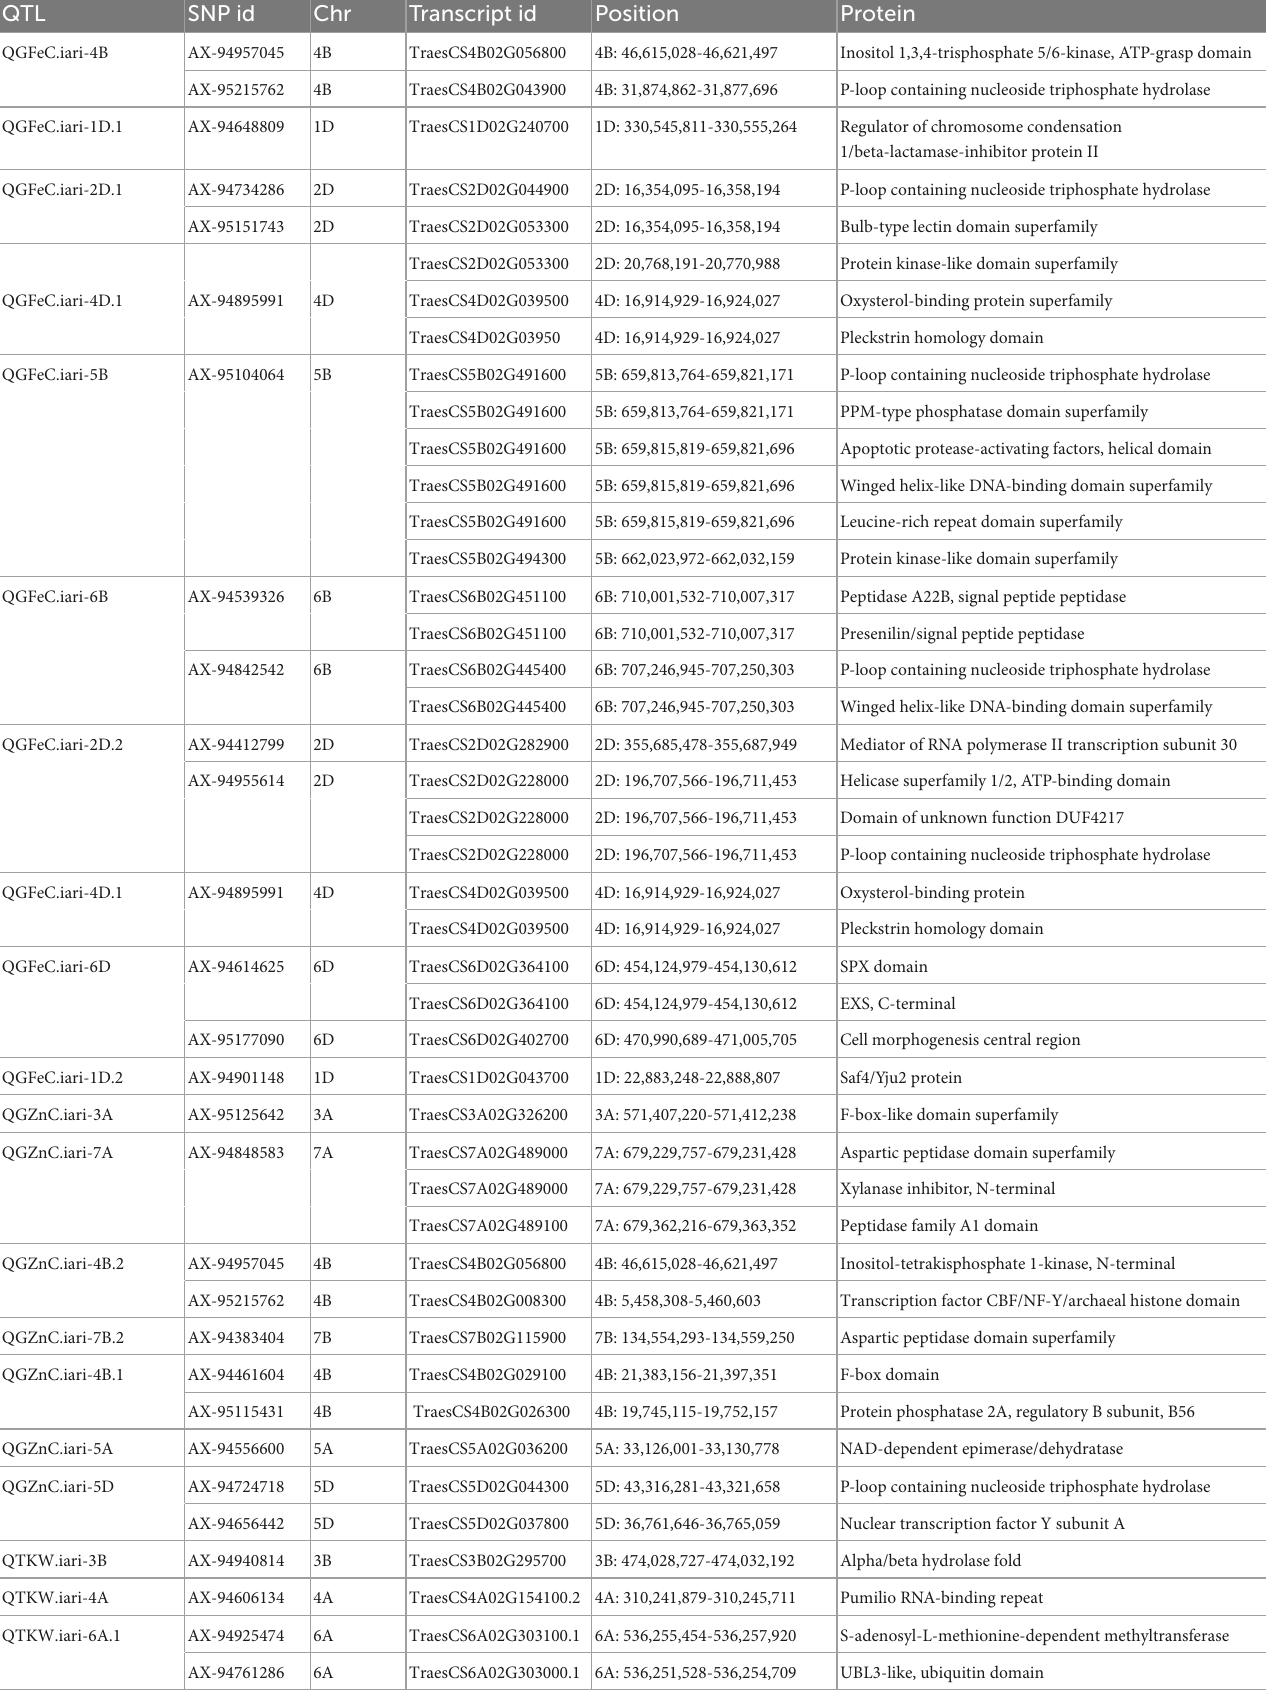
TABLE 7 Putative candidate genes identified in the QTL region and proteins